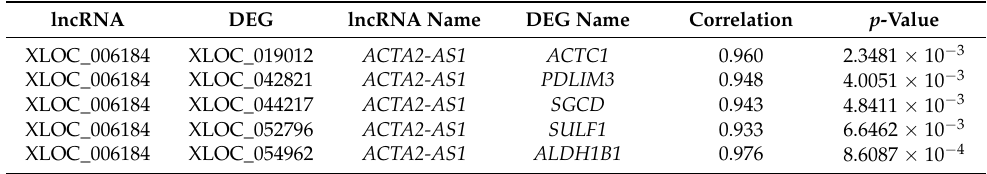
Table 5. Trans -relations between lncRNAs and differentially expressed genes in ff-FGR